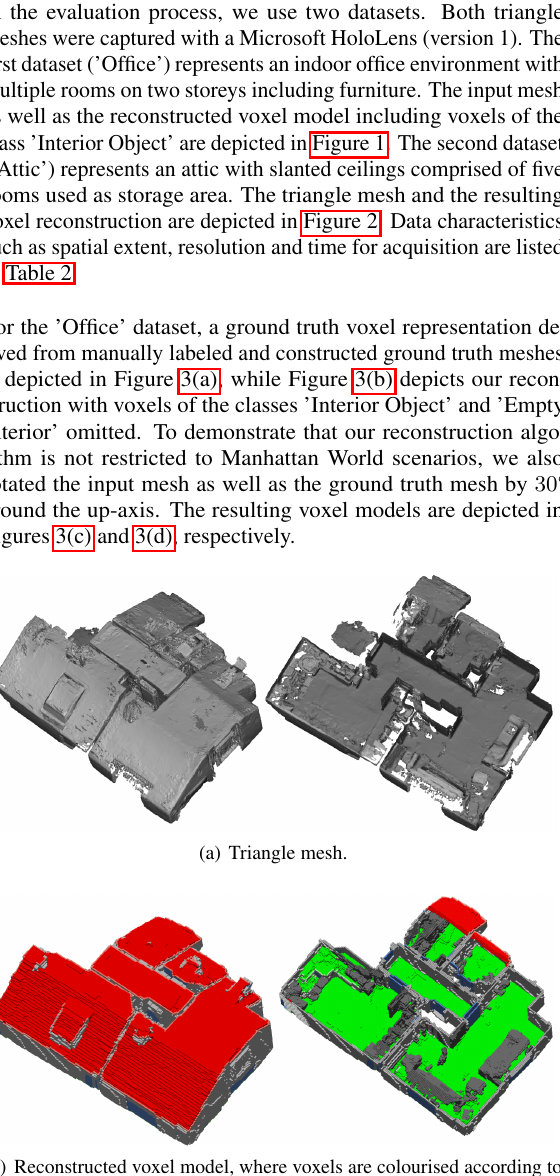
Figure 3. Voxelized ground truth data and reconstruction results for the ’Office’ dataset. Voxels are colourised according to Ta- ble 1(b). In each case, a part of the ceiling is removed for the sake of